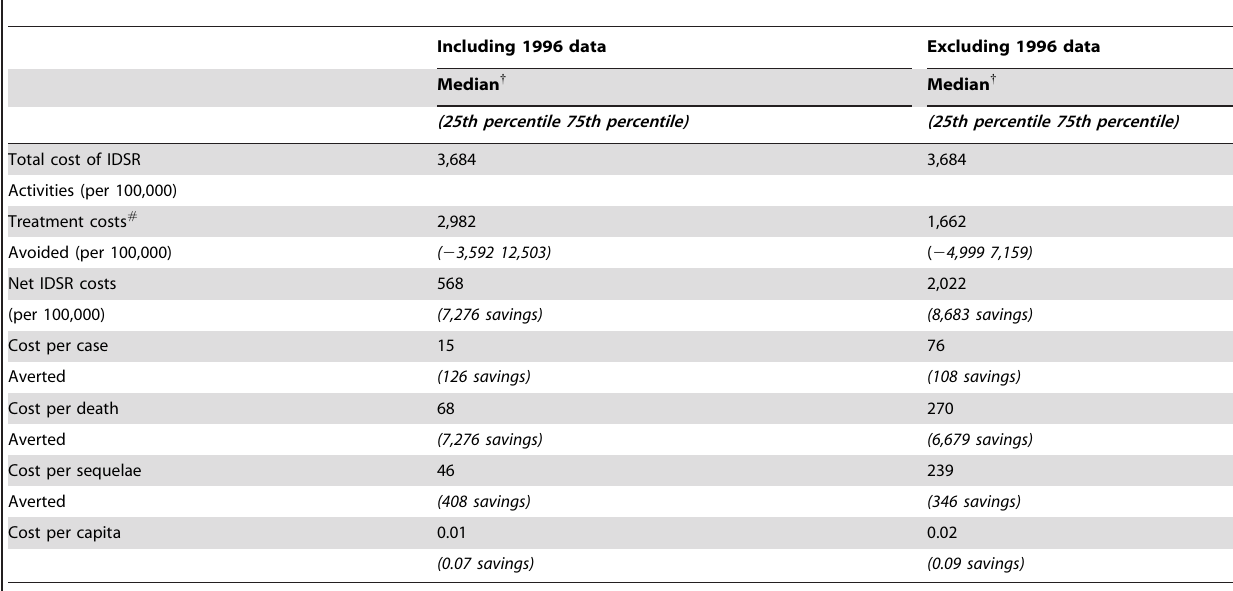
Table 4. Sensitivity analysis of total cost of IDSR, treatment cost of meningitis cases avoided, and cost-effectiveness * : Paired comparison of outbreaks before (1996–2002) and after (2003–2007) IDSR